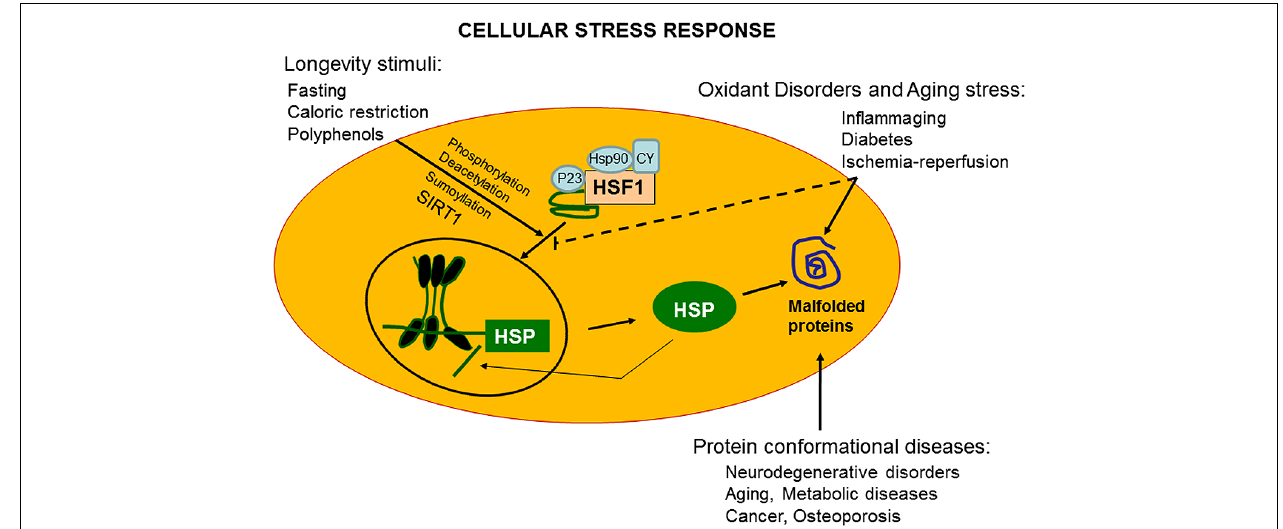
FIGURE 1 |Vitagenes and the pathway of cellular stress response. Misfolded proteins cumulating in response to proteotoxic stresses trigger the cellular stress response. Hsps that are normally bound to HSF1, maintaining it in a repressed state before stress, are titrate away by damaged or misfolded proteins with resulting HSF-1 activation. Multi-step activation of HSF1 involves post-translational modifications, such as hyperphosphorylation, deacetylation, or sumoylation, which allow HSF1 to trimerize, translocate into the nucleus, and bind to heat shock elements (HSEs) in the promoter regions of its target Hsp genes.